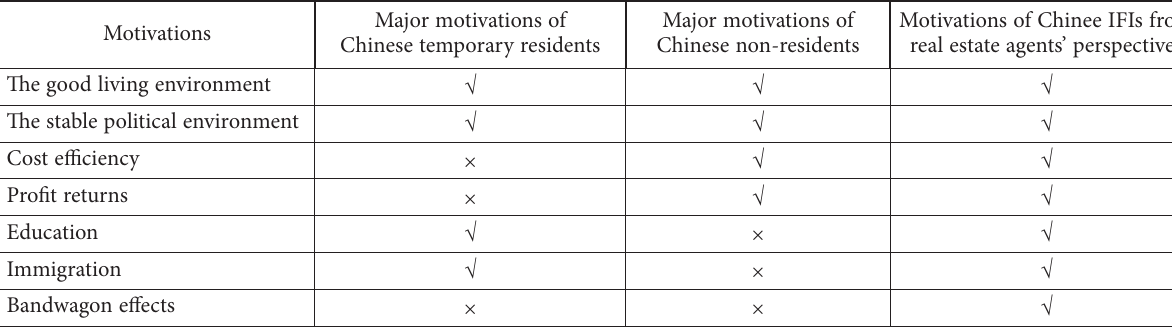
Table 1. Summary of motivations of Chinese IFIs from perspectives of Chinese temporary residents, Chinese non-residents and real estate agents in the Australian residential real estate